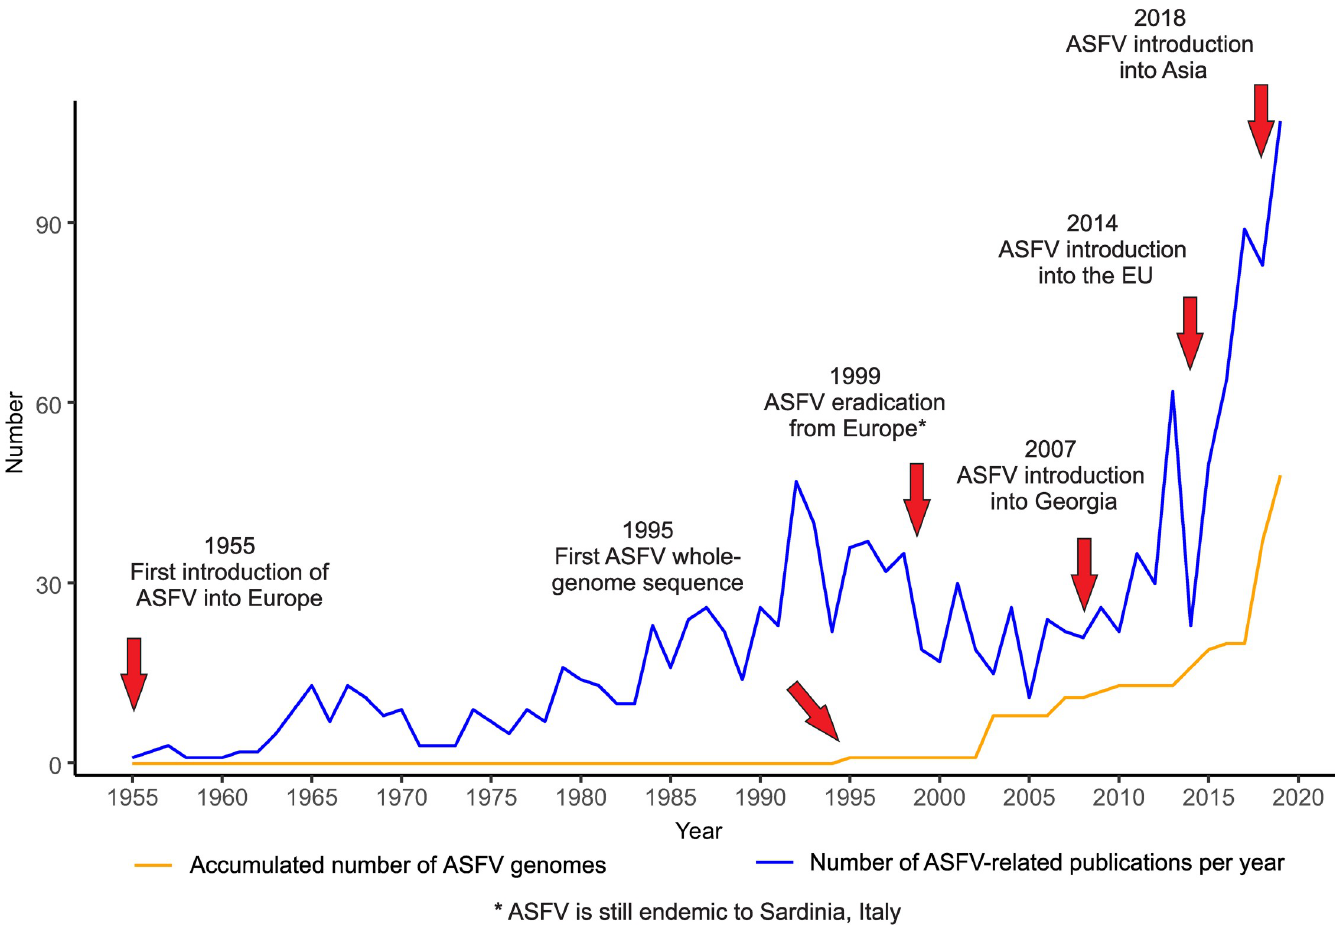
Fig 1. ASFV-related publications and whole-genome sequences over time. The number of publications related to ASFV per year (blue line) was extracted from NCBI-Pubmed on December 20, 2019, and the accumulated number of ASFV whole-genome sequences (orange line) was extracted from INSDC databases on December 20, 2019. Important events are highlighted (red arrows). ASFV, African swine fever virus; EU, European Union; INSDC, International Nucleotide Sequence Database Collaboration; NCBI, National Center for Biotechnology Information.